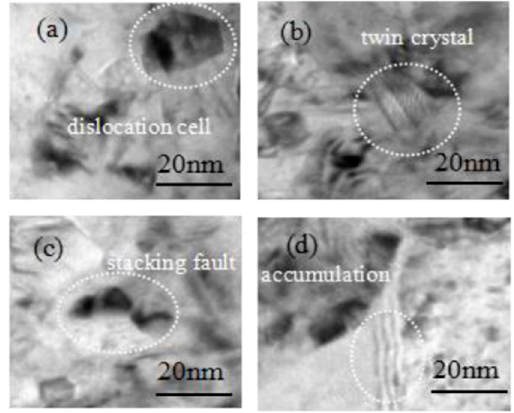
Figure 10. Images of the dislocation in the electroplated Ni coating (80 kHz,100 W): ( a ) dislocation cell; ( b ) twin crystal; ( c ) stacking fault; ( d ) dislocation accumulation.